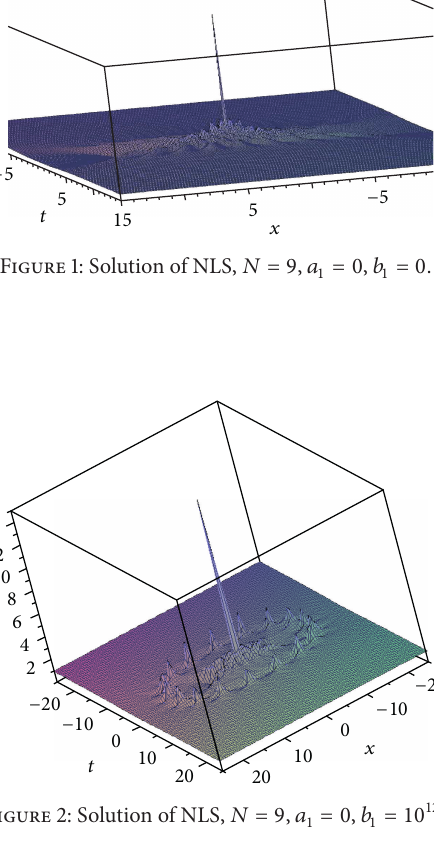
Figure 2: Solution of NLS, 𝑁 = 9 , 𝑎 1 = 0 , 𝑏 1 = 10 12 .